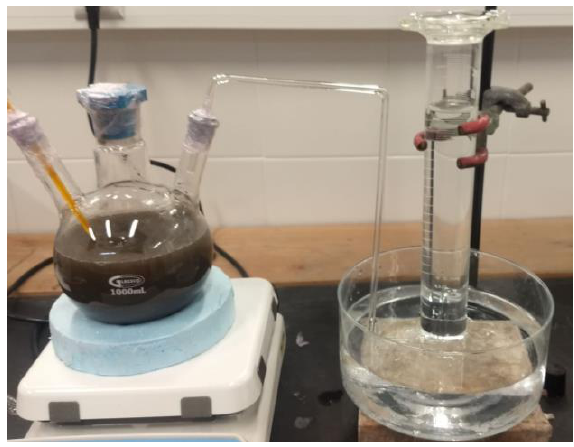
Figure 3. Setup for the quantification of metallic aluminium in